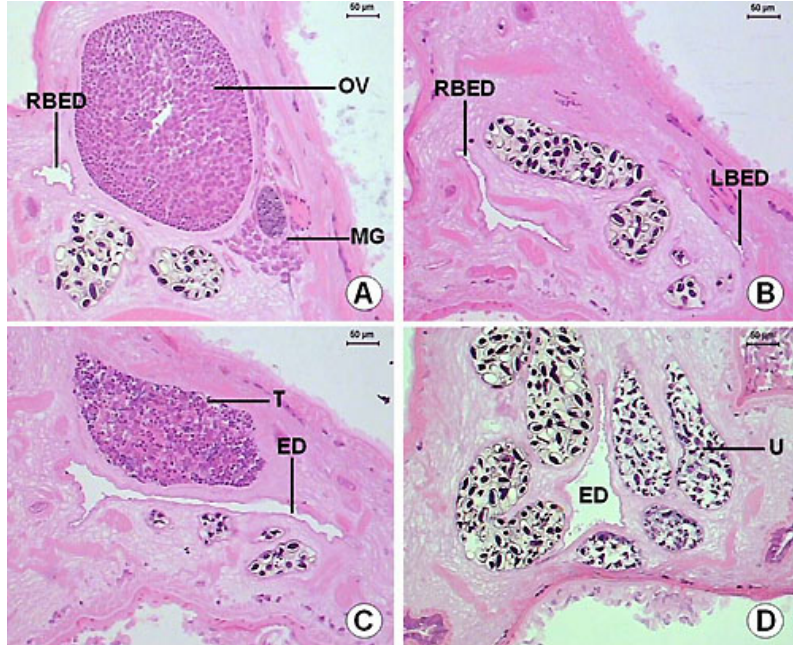
Figure 11. Transversal section of the excretory duct of Sticholecitha serpentis . A) beginning of the rigth brach of excretory duct in the ovary region, B) beginning of the left branch of excretory duct before the anterior testicle region, C) rigth and left branches merged in the testicle region, D) dorsal position of the excretory duct. ED – excretory duct, T – testicle, MG – Mehlis’ gland, LBED – left branch of excretory duct, RBED – rigth branch of excretory duct, OV – ovary, U – uterus.